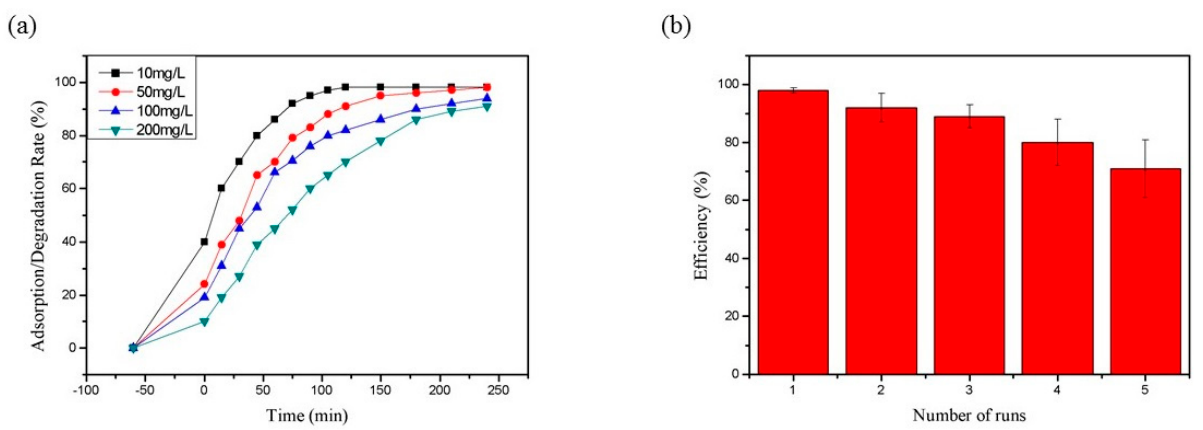
Figure 11. Performance of repetitive use of TiO 2 @CNF Aerogel: ( a ) Absorption and degradation of RhB by the TiO 2 @CNF aerogel, ( b ) The performance of aerogel recycling in 5 runs.